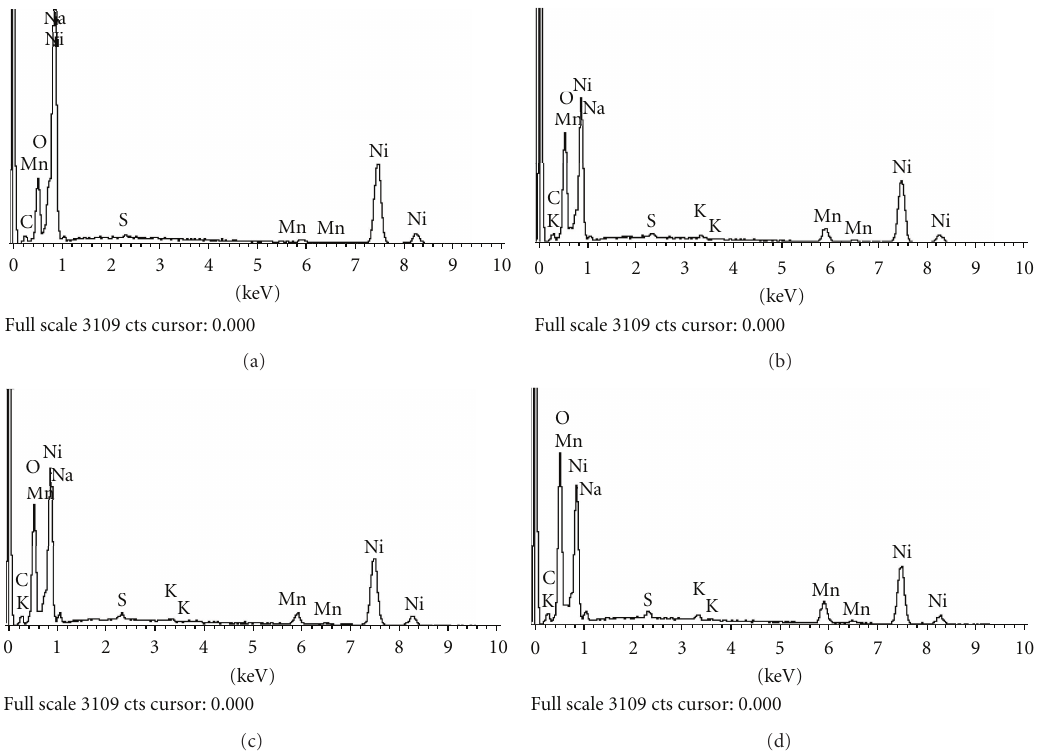
Figure 2: EDX spectra of self-assembled MnO 2 thin films on Ni-coated PET films at submersion duration of (a) 1 min, (b) 10min, (c) 30min, and (d) 60 min.